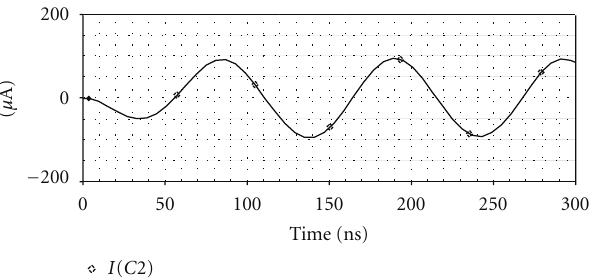
Figure 9: High-pass output at